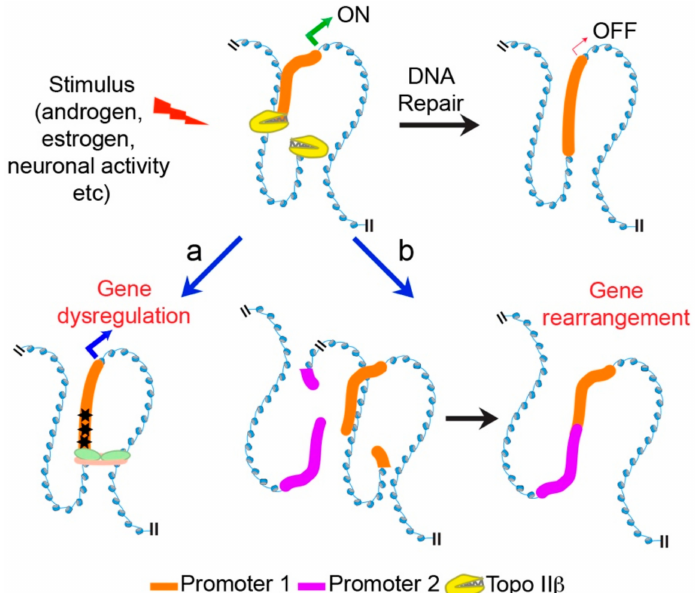
Figure 2. Defective repair of Topo II β -mediated DNA DSBs and disease. (Black arrow) The generation and accurate repair of Topo II β -mediated DSBs controls activity-induced gene expression in a number of systems. (Blue arrows) Two scenarios by which defective repair of stimulus-induced DSBs could lead to disease are depicted: ( a ) inaccurate repair leads to the accumulation of mutations (black stars) within the promoters of stimulus-responsive genes, and dysregulates their expression. For instance, disruption of ERG induction in neurons could reduce cognitive performance. ( b ) Aberrant recombinogenic repair of activity-induced DSBs could lead to gene arrangements. For instance, more than 50% of prostate cancer patients harbor recurrent gene